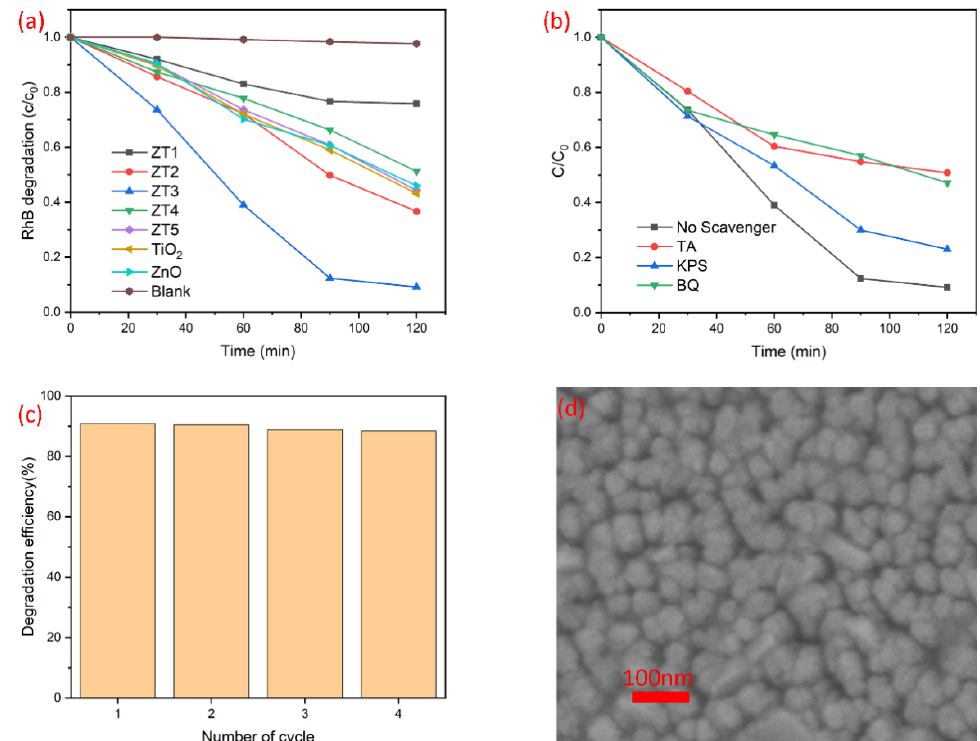
Figure 9. ( a ) The photocatalytic degeneration of RhB over ZT1, ZT2, ZT3, ZT4, and ZT5; ( b ) the photocatalytic degeneration of RhB with various scavengers over ZT3; ( c ) the stability of the ZT3; and ( d ) the SEM image of ZT3 after the photocatalytic test.